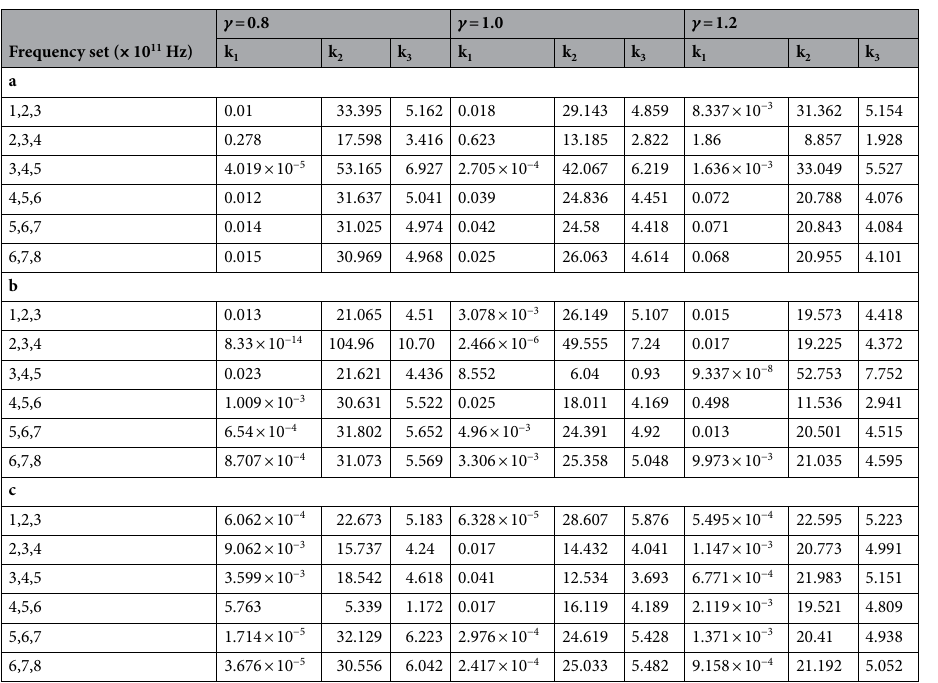
Table 1. It lists all the values of k 1 , k 2 and k 3 obtained during the validation process. In this table (a) δ = 3, (b) δ = 3.5 and in (c) δ = 4.0 and the value of γ is varied as 0.8, 1 and 1.2 for each δ